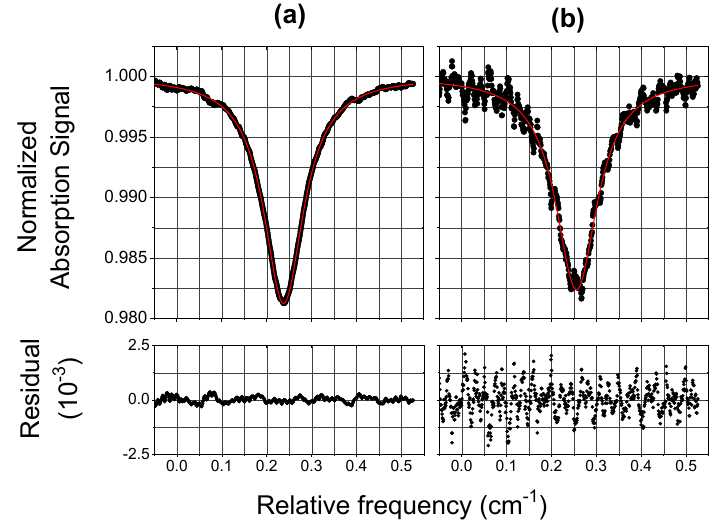
Figure 6. Normalized absorption spectra of a 125 ppbV CO mixture (scatter) and Voigt fit results (red line). The residual of the fitting procedure is shown in the bottom graph. The acquisition time is 1 s. The measurement was carried out at ambient pressure and at a temperature of 295 K. The effect of the PZT in the multipass cell is also shown: ( a ) PZT on; ( b ) PZT off.